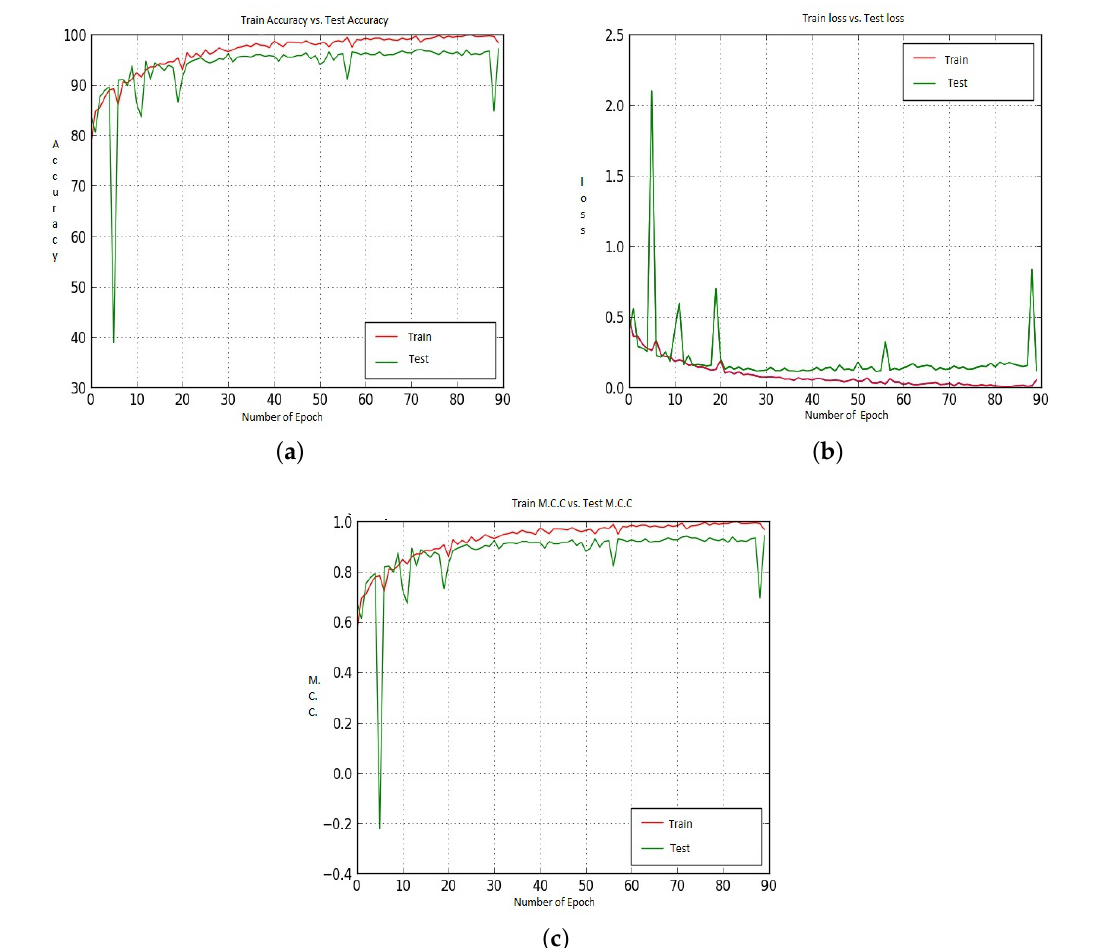
Figure 14. ( a – c ) represent the Train and Test Accuracy, Loss and M.C.C. values when we utilized Model-1, CNN-CH on the 200 ×